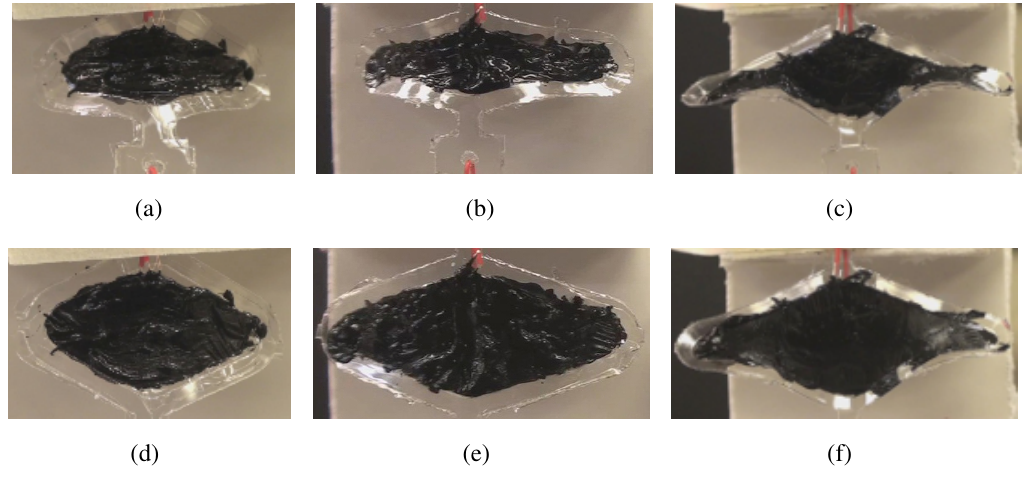
Figure 6. Miniature DEMES actuators. ( a , b ) The actuation from zero to maximum voltage of a diamond DEMES with a 12.5-mm maximum length. ( c , d ) The actuation from zero to maximum voltage of a bowtie with a maximum length of 23.5